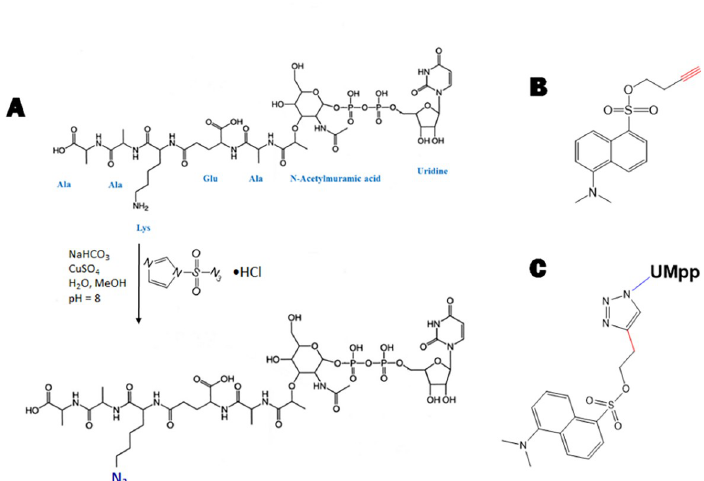
Fig 1. UDP-MurNAc-pentapeptide synthesis. (A) The principle of the reaction where the amine group of the lysine in UDP-MurNAc-pentapeptide was converted to azide through diazo transfer. (B) Structure of dansyl alkyne. (C) Structure of dansylated UDP-MurNAc-pentapeptide obtained through Cu(I) catalyzed azide-alkyne Huisgen cycloaddition.